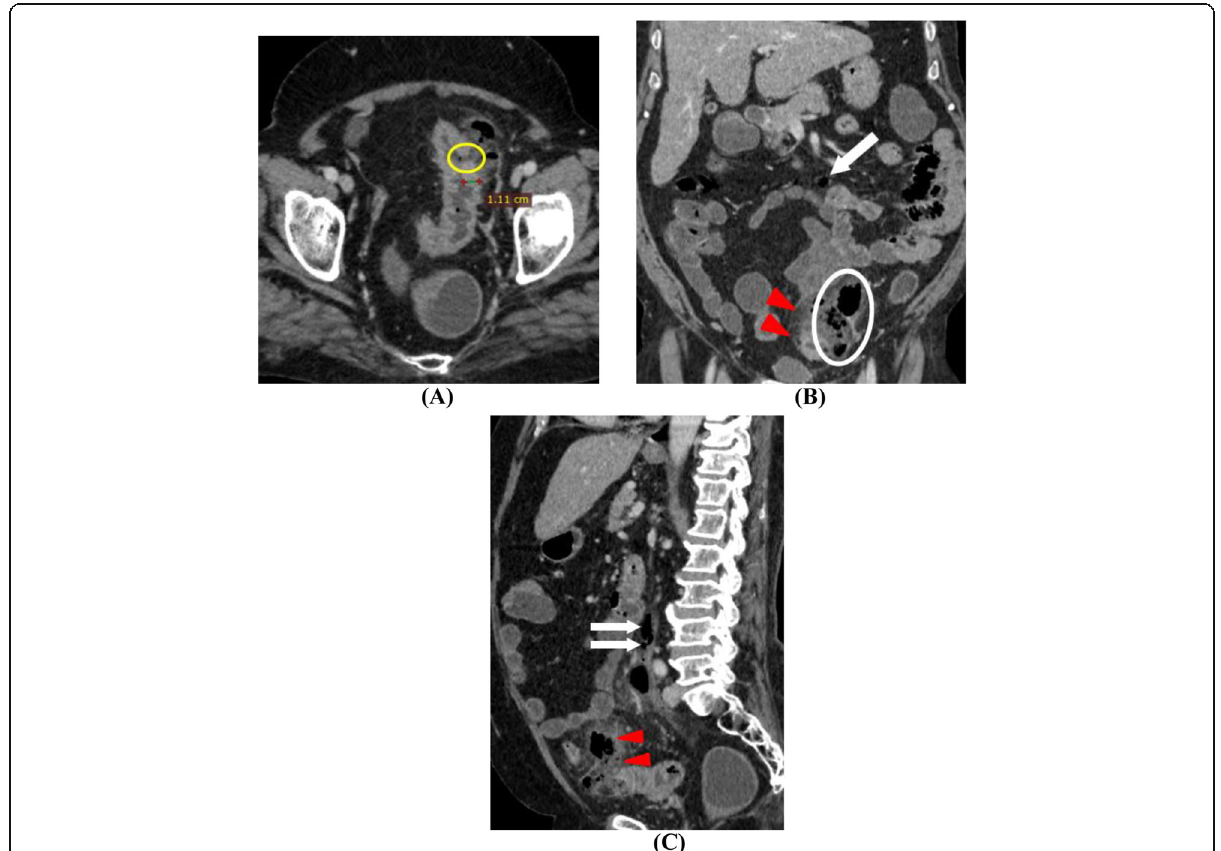
Fig. 12 Acute perforated diverticulitis in a 67-year-old female patient presented with acute abdominal pain. CT abdomen and pelvis images following water enema and intravenous contrast injection. a Axial image showing sigmoid wall thickening with focal mural defect (yellow circle). b Coronal and c sagittal images, showing gas-containing abscess (white circle), extra luminal air (arrows), and related extensive fat standing